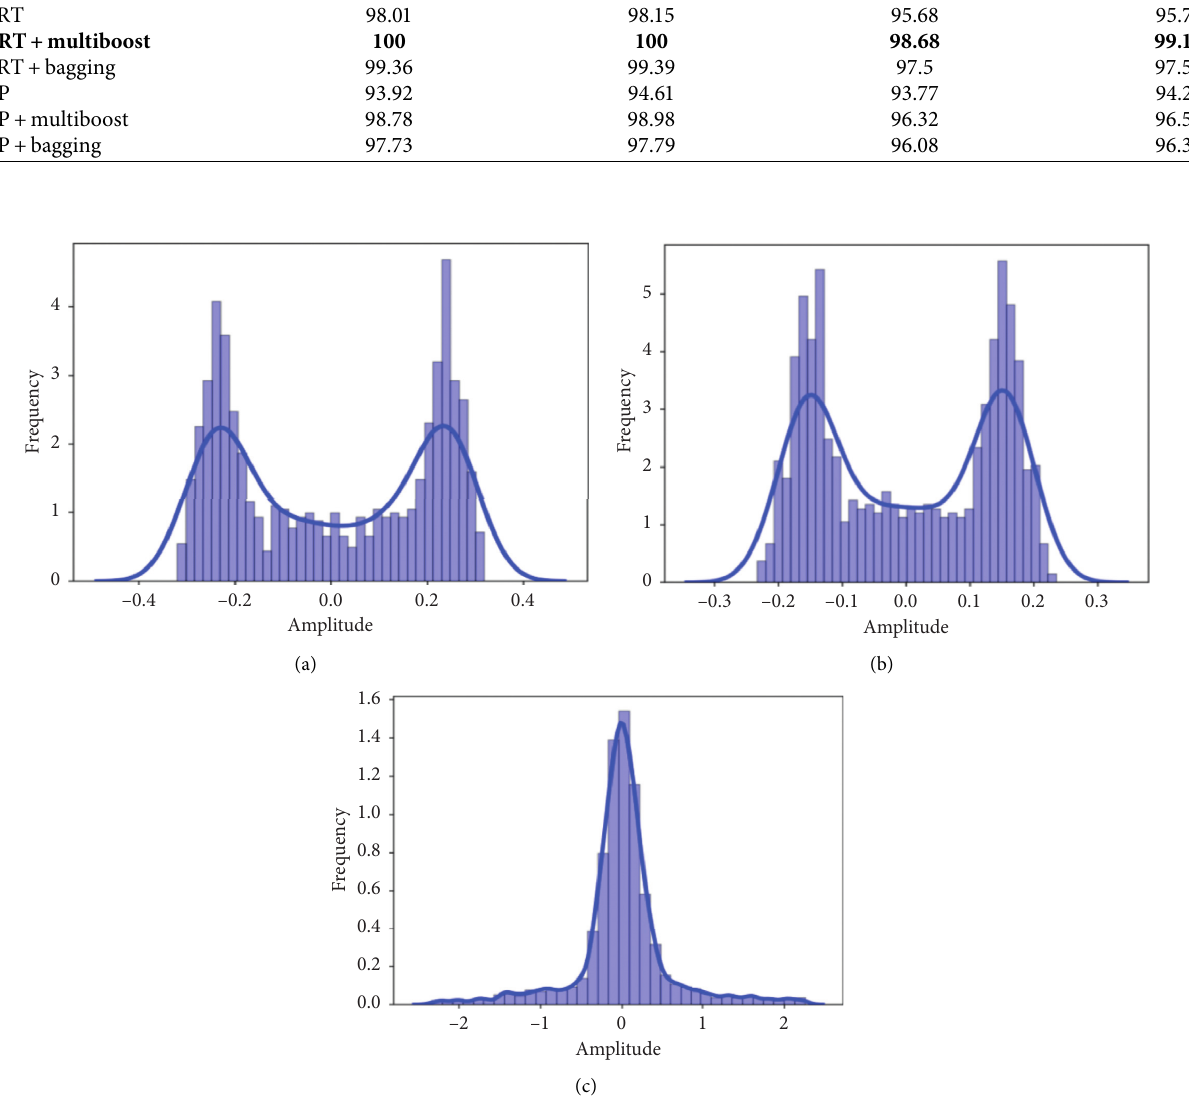
Figure 6: Frequency distribution histograms with fitting curves for selected samples. (a) Sample 1. (b) Sample 2. (c) Sample 3. Table 15: Comparison of normal negative log likelihood for Gaussian mixture models with normal negative log likelihood for single Gaussian for selected